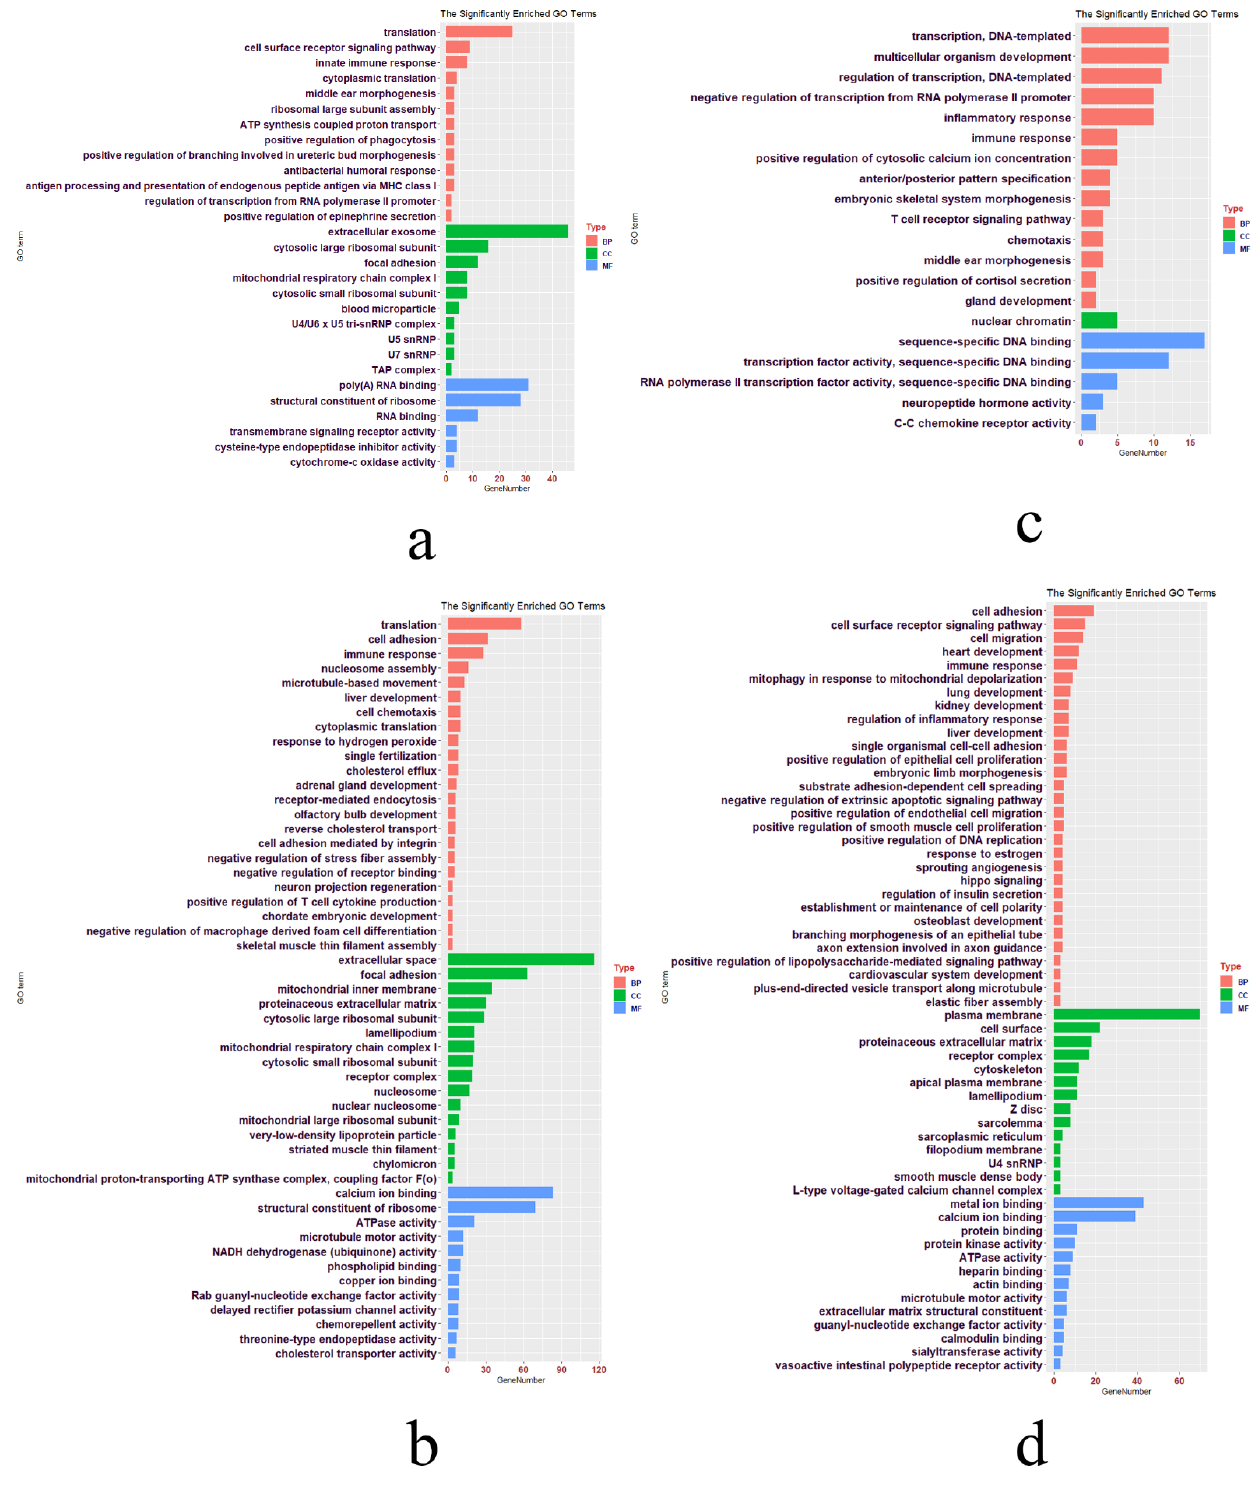
Figure 4. GO terms for four groups of DEGs (hypothalamus and ovary in FM_1-vs-NM_1 and FM_2-vs-NM_2). BP refers to biological process, CC refers to cellular component, and MF refers to molecular function. The GO terms for the hypothalamus ( a ) and ovary ( b ) in the FM_1 -vs- NM_1 group. The GO terms for the hypothalamus ( c ) and ovary ( d ) in the FM_2 -vs- NM_2 group.